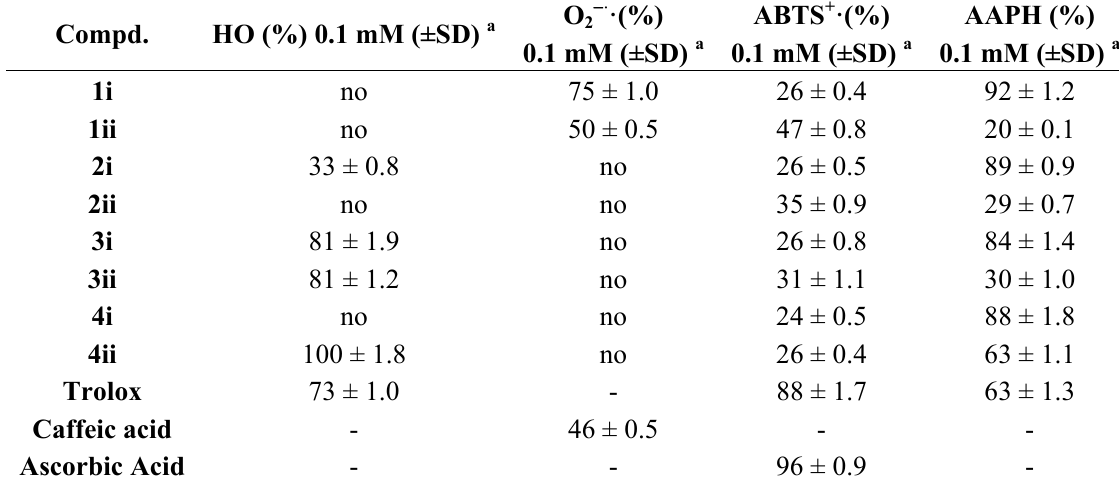
Ascorbic Acid - - 96 ± 0.9